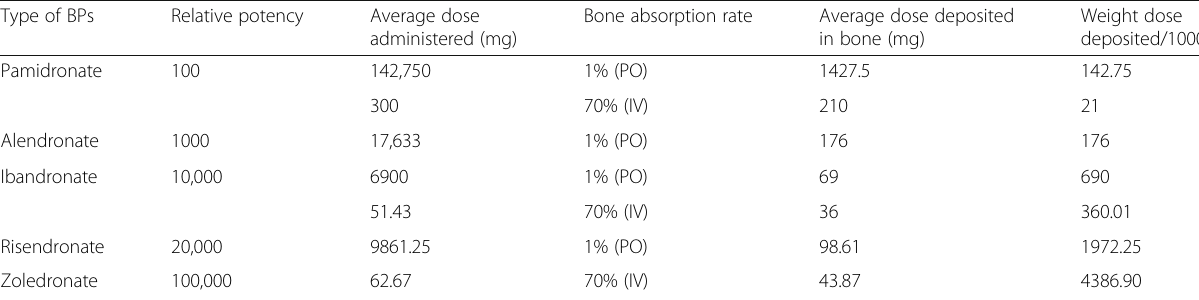
Table 2 Main characteristics of bisphosphonates (BPs)